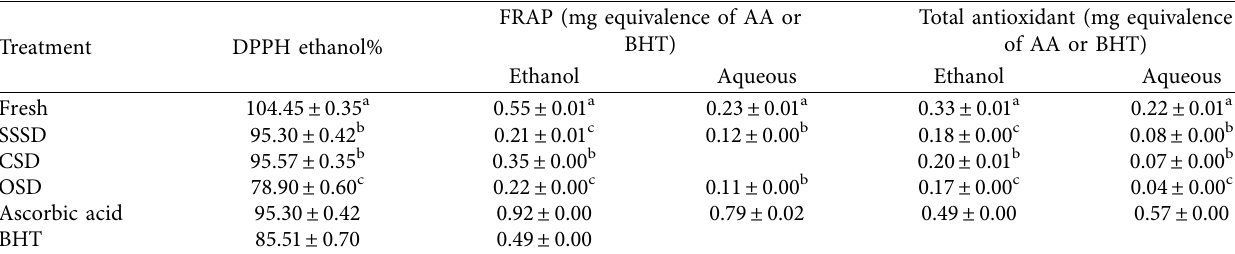
Data is represented as mean ± standard deviation of three replicate readings. Means in a column with different superscripts are significantly different at p ≤ 0 . 05. CSD: tent-like concrete solar-dried ginger rhizome. SSSD: stainless steel solar-dried ginger rhizome. OSD: open-sun-dried ginger rhizome.